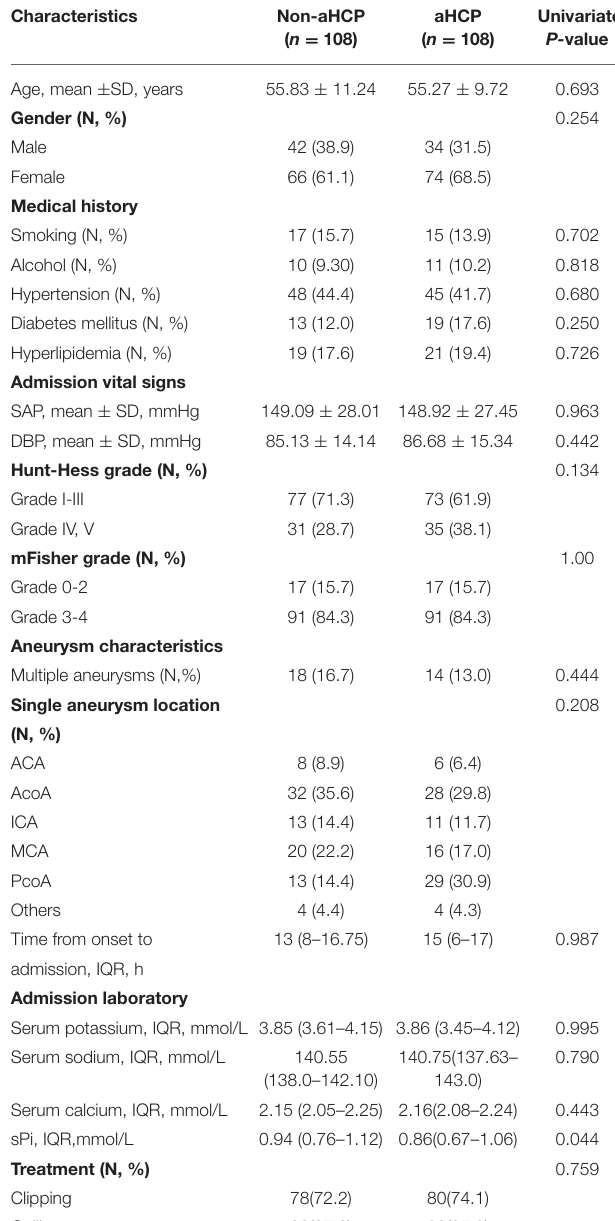
0.001; Figure 3D ), respectively. Correlation analyses revealed a negative correlation between sPi and SBP ( r = − 0.137, P = 0.001). No correlation was detected between sPi and age or sex ( P >0.05).